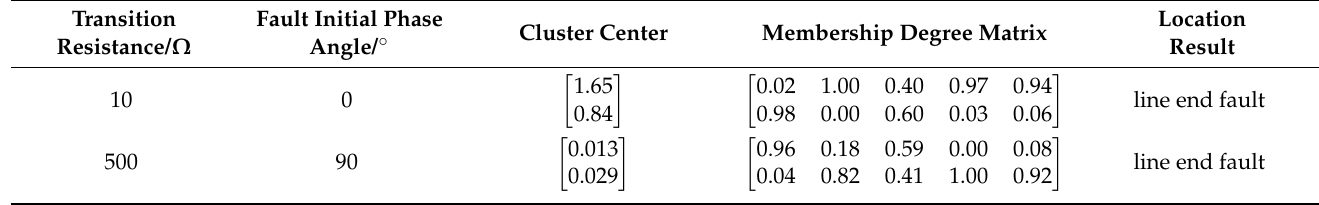
Table 4. Location results of line-end faults.